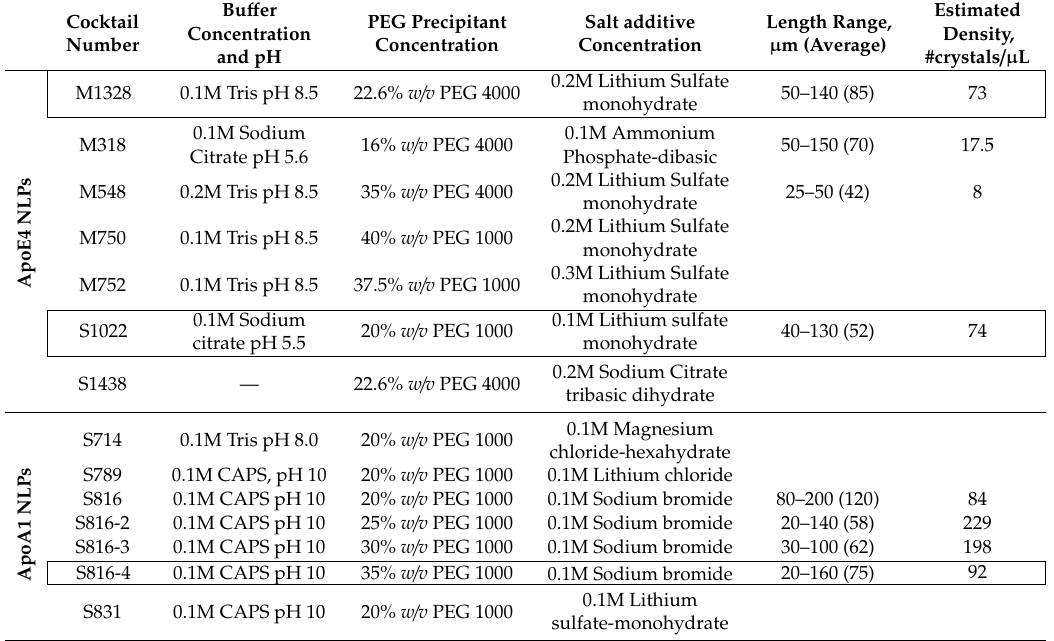
Table 1. Compositional characteristics, crystal sizes, and approximate crystal densities for crystallization conditions reproduced at Lawrence Livermore National Laband chosen to optimize for SFX experiments to maximize reproducibility, crystal uniformity, and crystal density for apolipoproteins ApoA1 and ApoE4. Boxed conditions were measured in SFX experiments at Linac Coherent Light Source